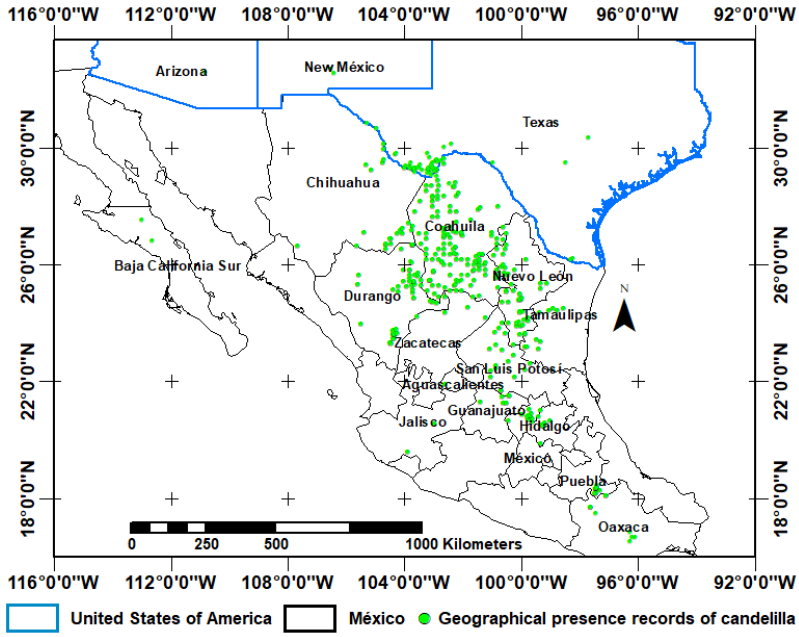
Figure 1. Presence sites of candelilla in North America, extracted from the Global Biodiversity Information Facility (GBIF).